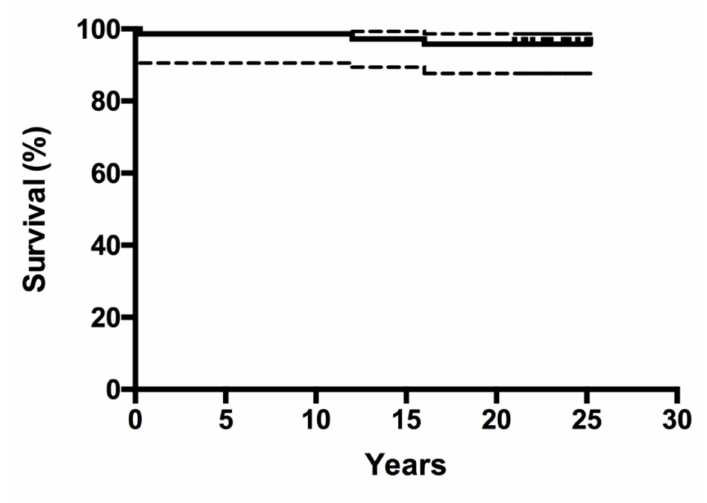
Figure 2. Kaplan–Meier survivorship curve (and corresponding 95% confidence intervals) for all seventy-two hips, with revision of the stem for any reason as the end point.